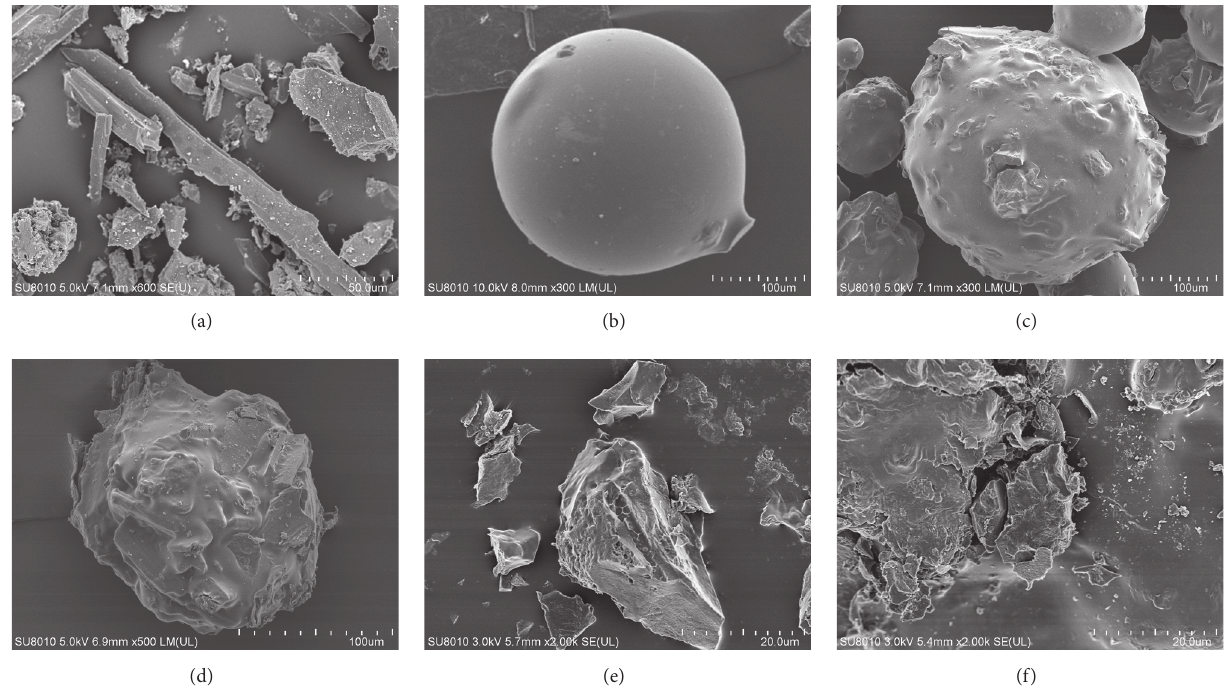
Figure 2: SEM photos: (a) activated carbon powder, (b) CA0, (c) CA1, (d) CA3, (e) surface of CA4, and (f) surface of CA5.